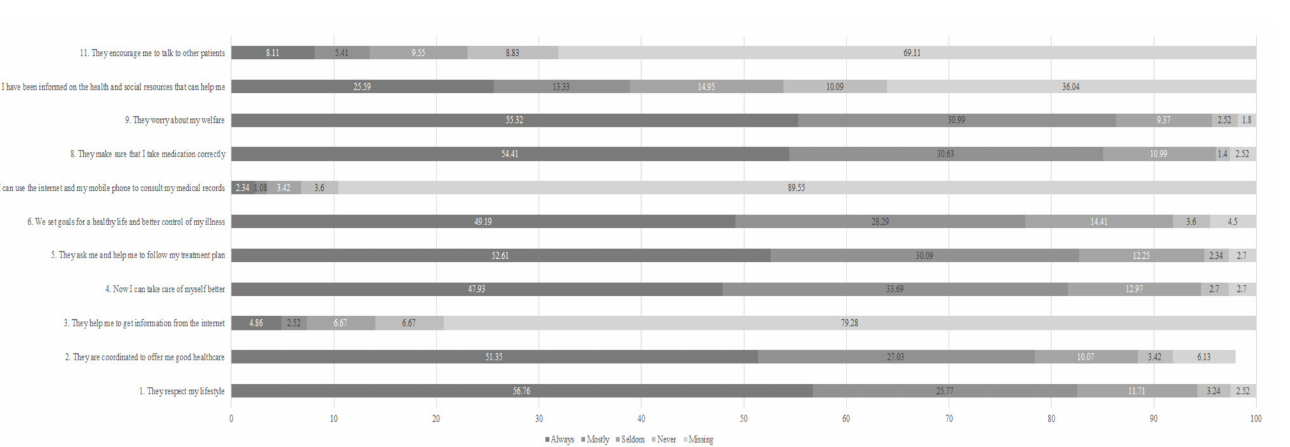
Figure 1. Distribution of patients’ responses to IEXPAC items. Numbers in bars represent the percentage of respondents who responded to each